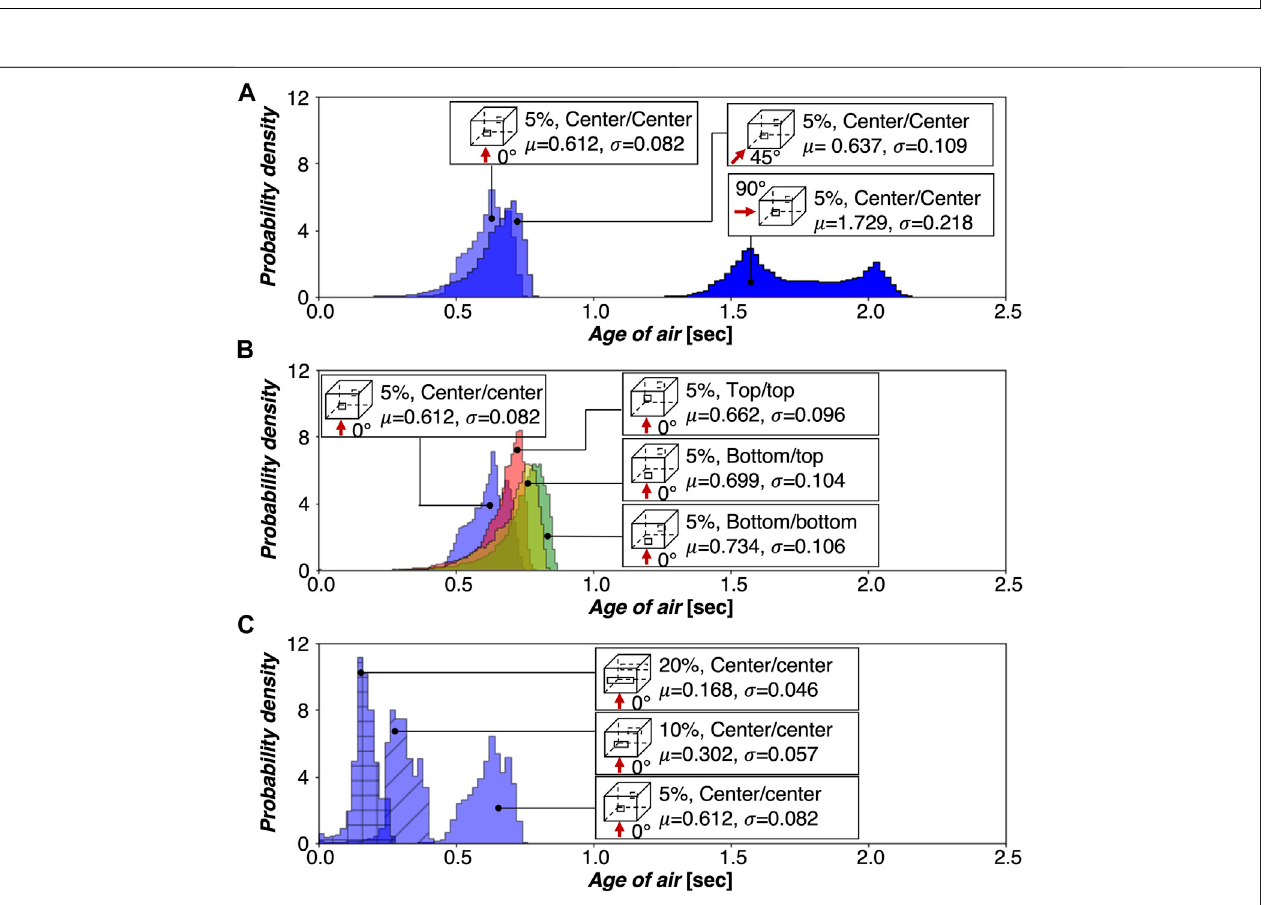
FIGURE 11 | Distribution of age of